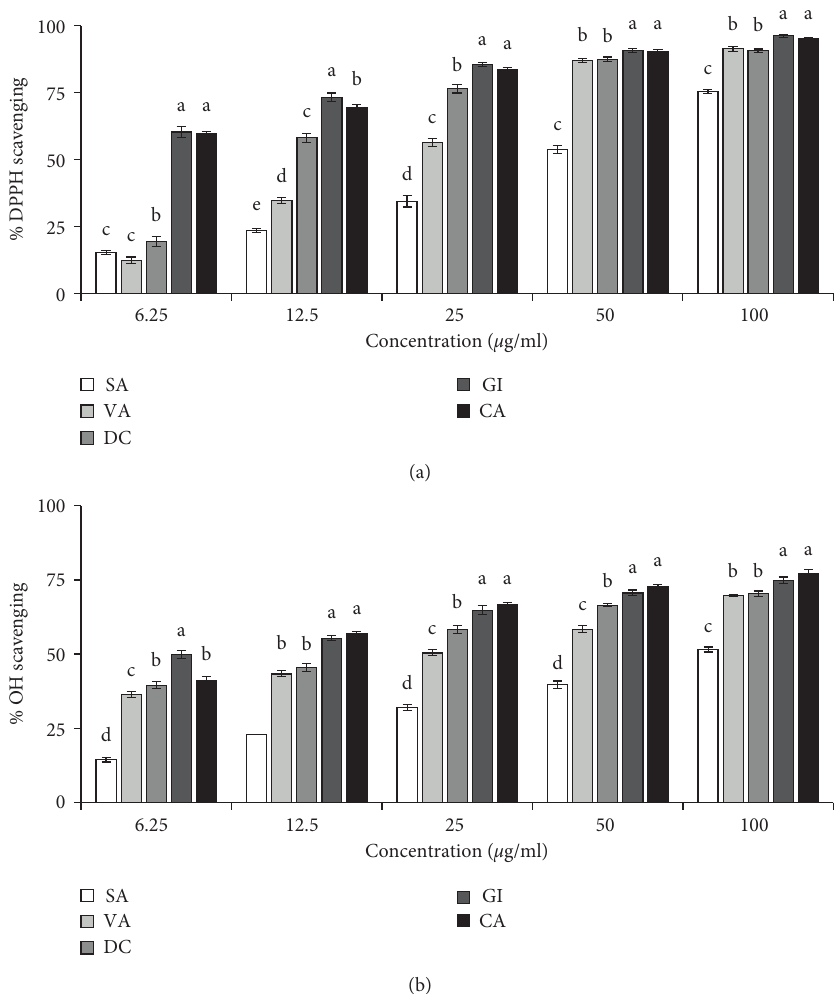
Figure 3: Radical scavenging activity of the isolated compounds. (a) DPPH radical scavenging. IC 50 ( μ g/ml): SA, 40.64 ± 1.68; VA, 19.64 ± 0.73; DC, 12.16 ± 0.55; GI, 4.16 ± 0.37; CA, 4.35 ± 0.09. (b) Hydroxyl radical scavenging. IC 50 ( μ g/ml): SA, 91.05 ± 3.75; VA, 21.72 ± 0.87; DC, 15.07 ± 1.20; GI, 6.61 ± 0.76; CA, 9.32 ± 0.39. Catechin (CA) was used as a reference antioxidant. Results represent mean ± SD ( n � 3). Compound 1 had no activity and was not shown. Means with different letters (a–e) differ significantly ( P < 0 . 05). SA, syringaldehyde; VA, vanillin; DC, dihydroconiferyl dihydro- p -coumarate; GI, gigantol; CA,